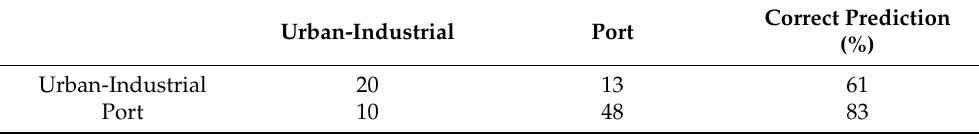
Table 3. Confusion matrix in cross validation and percentage of correct